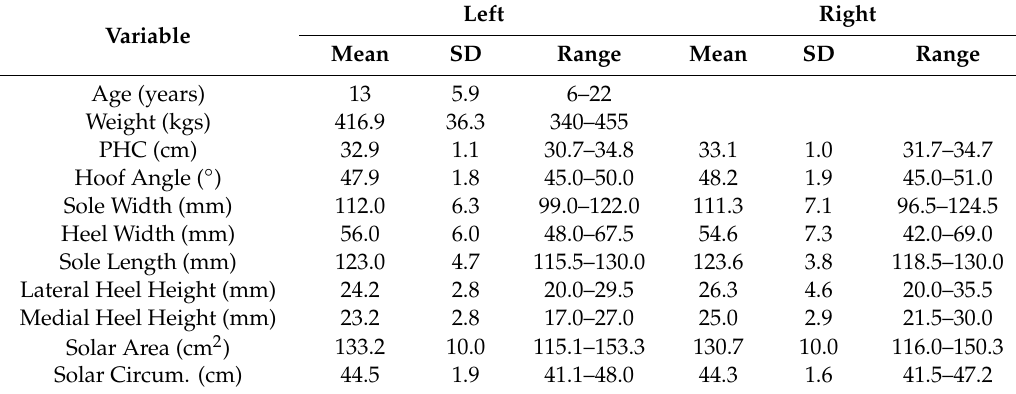
Table 1. The starting values at the beginning of the study displayed as the mean ( n = 11), standard deviation (SD), and range for the left and right front hooves.